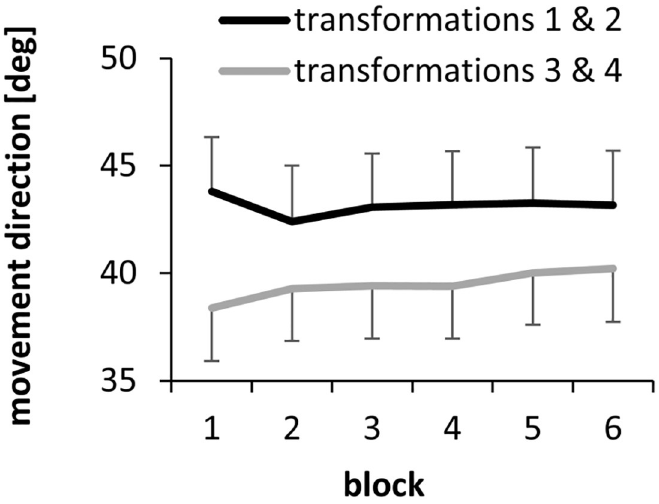
Fig 5. Progress of adaptation across blocks in the first and second compared to the third and fourth adaptation task. 65˚ represents the expected value for complete adaptation. 0˚ represents the unadapted expectation. Illustrated are between-subject means and standard errors.